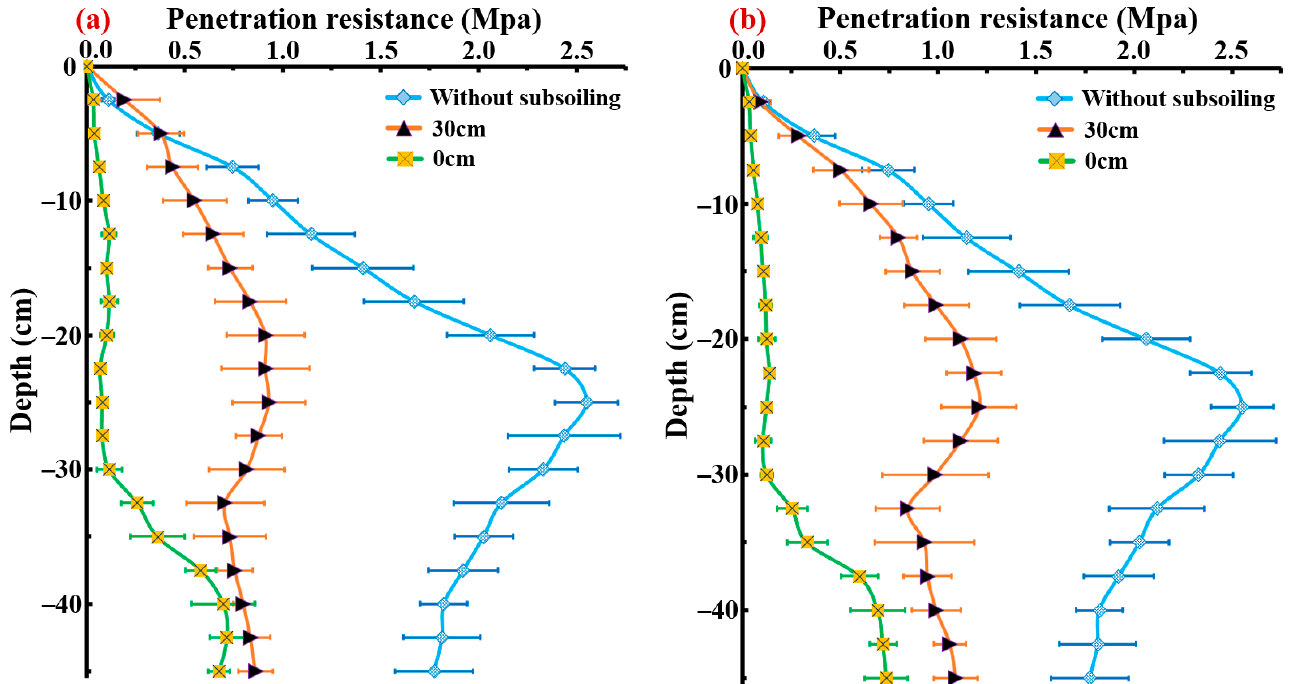
Figure 16. Variation of soil firmness with depth before and after subsoiling: ( a ) The changes of soil firmness without vibration subsoiling; ( b ) the changes of soil firmness with vibration subsoiling.